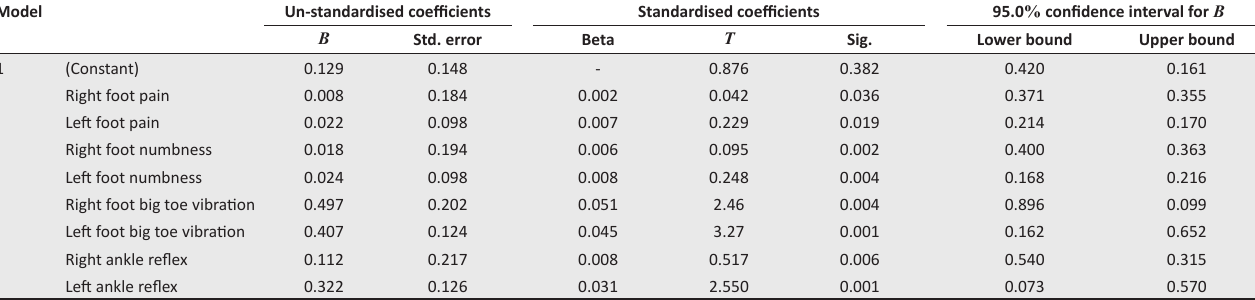
TABLE 4c: Regression results of demographic characteristics and peripheral neuropathy domains. (c) Individual significance. Model